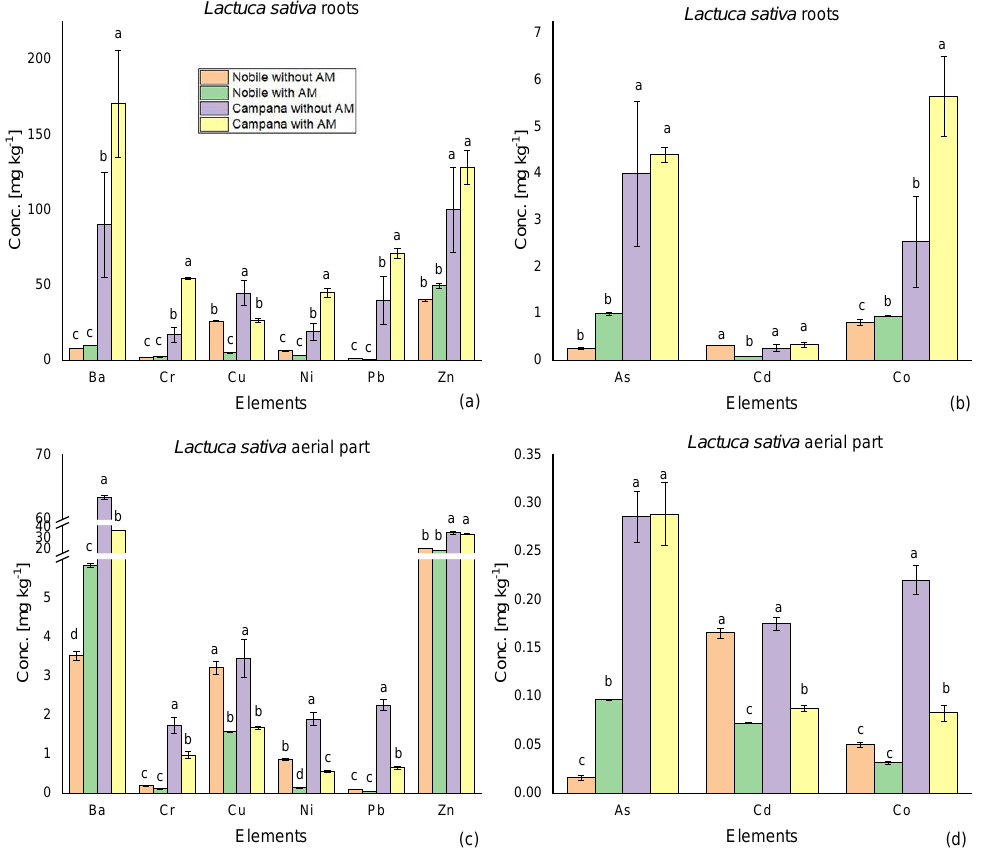
Figure 2. Comparison of potentially toxic elements’ uptake in the roots ( a , b ) and in aerial part ( c , d ) of Lactuca sativa grown in CA and NOB soils. Elements concentrations are expressed as mg kg − 1 dry weight. Letters above columns refer to the summary of multiple comparisons for pairs obtained with Tukey test. Letter b identifies plant samples whose mean concentrations in the respective elements are significantly lower than the ones obtained for plant samples identified by letter a ; the same concept applies to letter c with respect to letter b and letter d with respect to letter c .